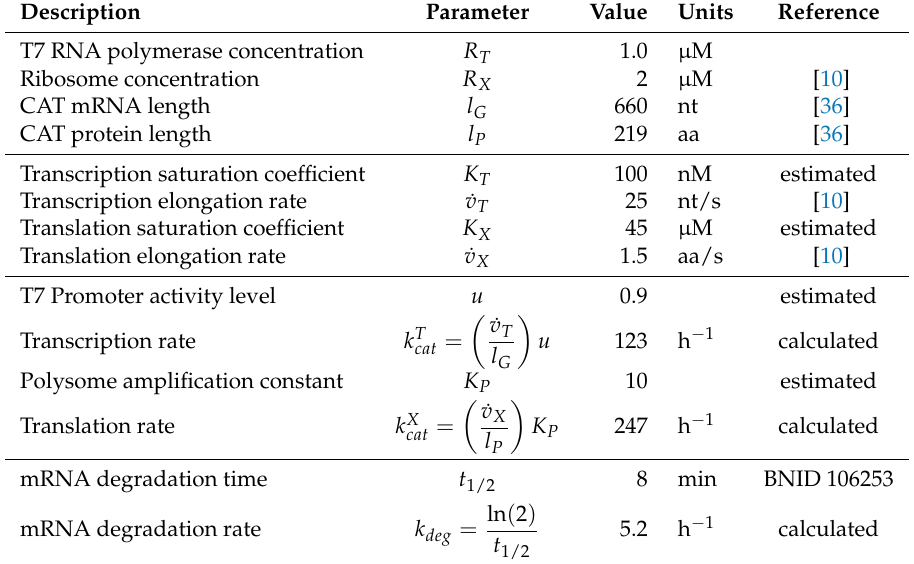
Table 1. Reference values for transcription, translation, and mRNA degradation from literature. Transcription rate calculated from elongation rate, mRNA length, and promoter activity level. Translation rate calculated from elongation rate, protein length, and polysome amplification constant. The mRNA degradation rate calculated from a characteristic mRNA half-life. CAT: chloramphenicol